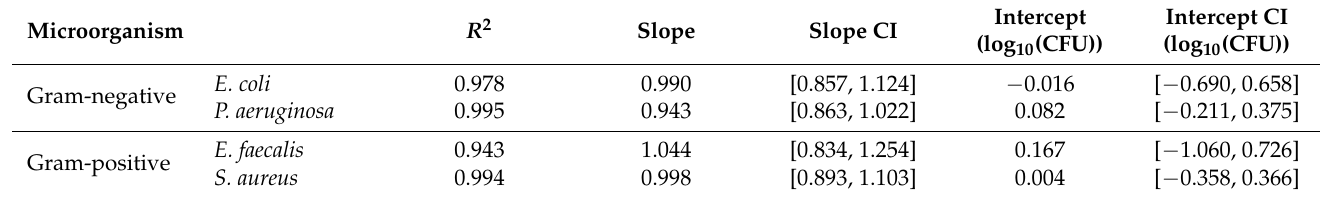
Table 4. Parameters of the single linear regressions established between decimal logarithmic of the CFU predicted (LOO-CV) by the E-nose-MOS-MLM and the decimal logarithmic of the CFU experimentally determined by the conventional plate counting technique: coefficient of determination ( R 2 ); slopes, intercept values and respective confidence intervals (CI) at